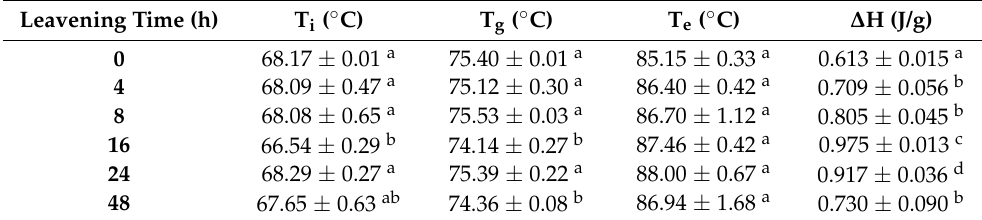
Values are mean ± SD ( n = 3). Di ff erent le tt ers indicate samples signi fi cance calculated by an ANOVA statistical test with Post Hoc Tukey ( p < 0.05).